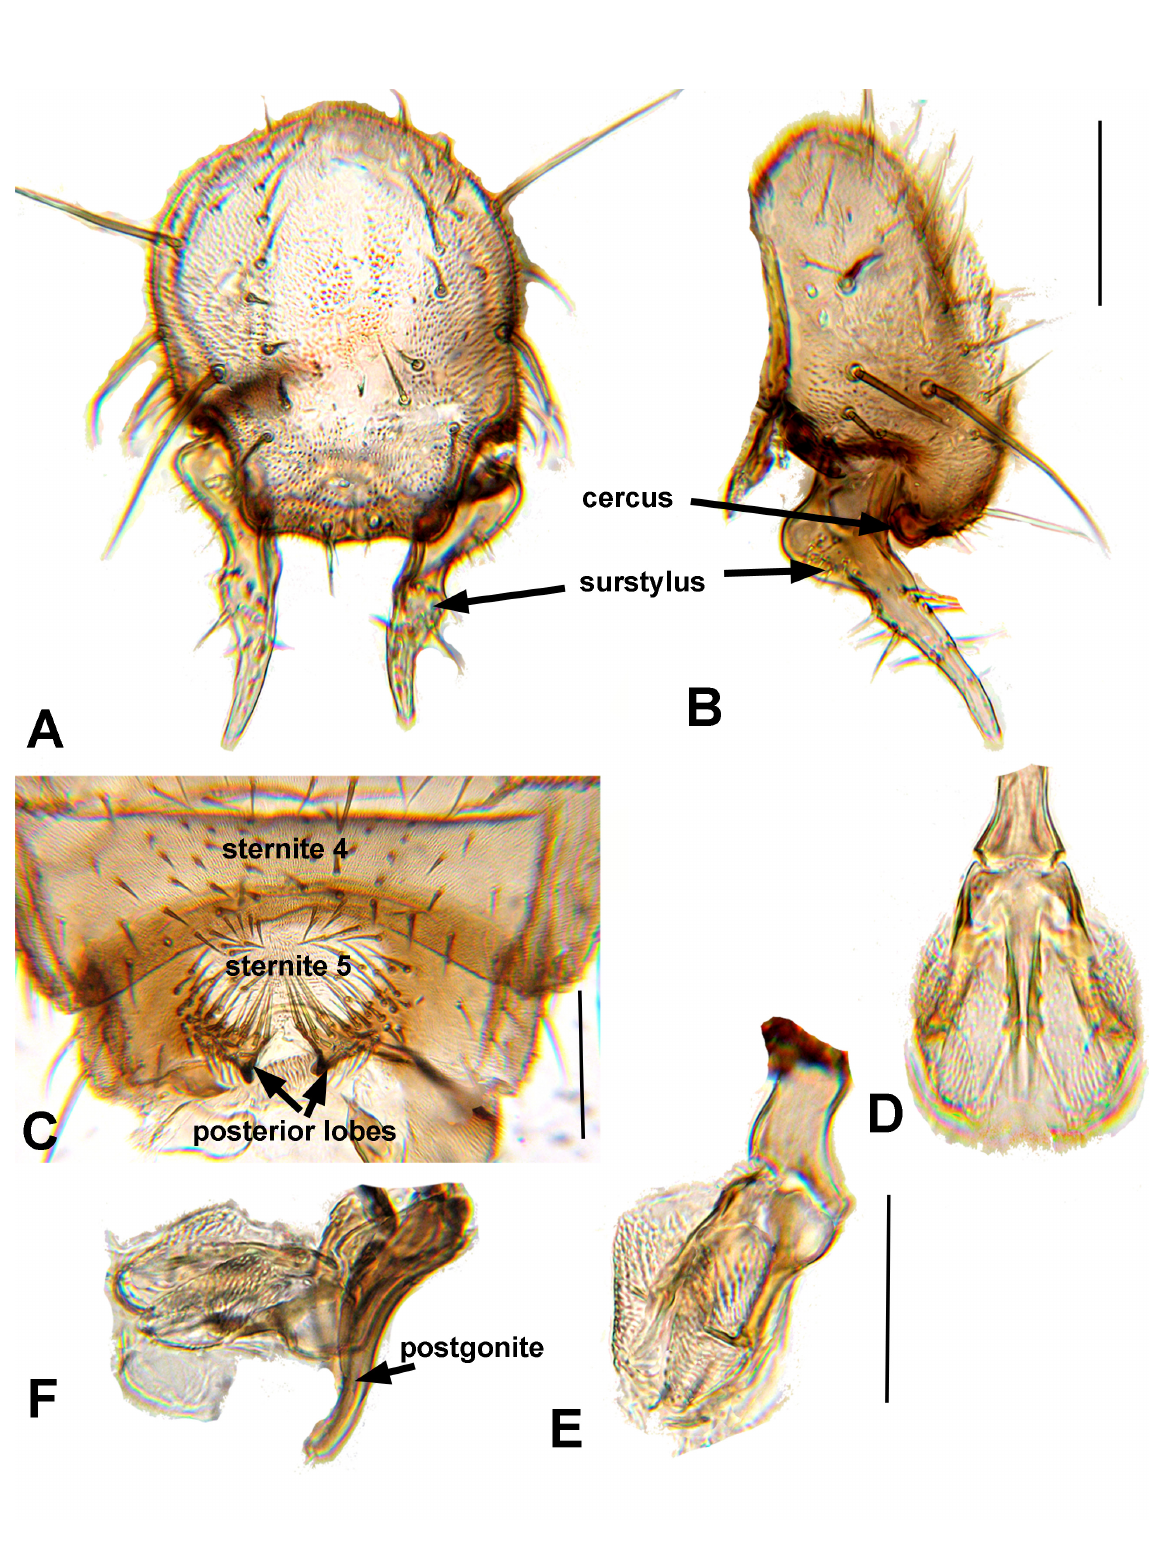
Fig. 14. Rudolfina newtoni sp. nov., male terminalia (A–E: debu01086234; F: debu01086234). A . Epandrium, surstylus and cercus, caudal view. B . Same as preceding, lateral view. C . Sternites 4 and 5, ventral view. D . Phallus, dorsal view. E . Phallus, dorsolateral view. F . Phallus and postgonite, lateral view. Scale bars: A–B = 0.10 mm; C = 0.10 mm; D–F = 0.05